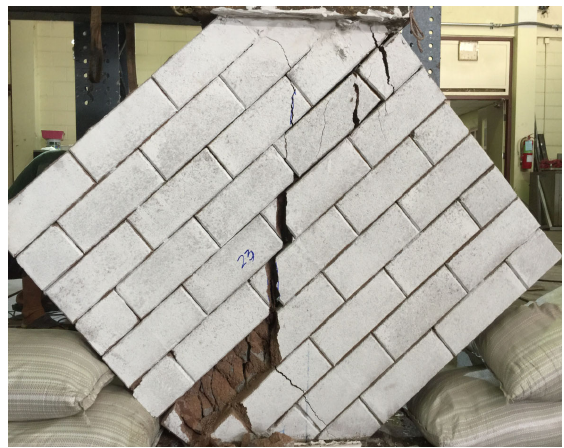
Figure 12. Cracking of control wall at load 247 kN.